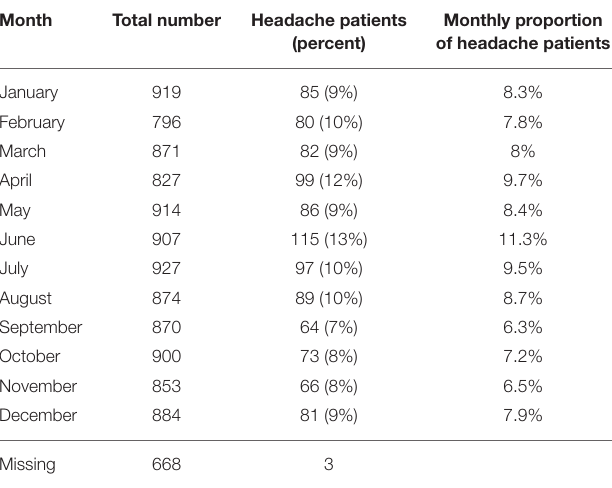
TABLE 5 | Average number of patient-presentation per